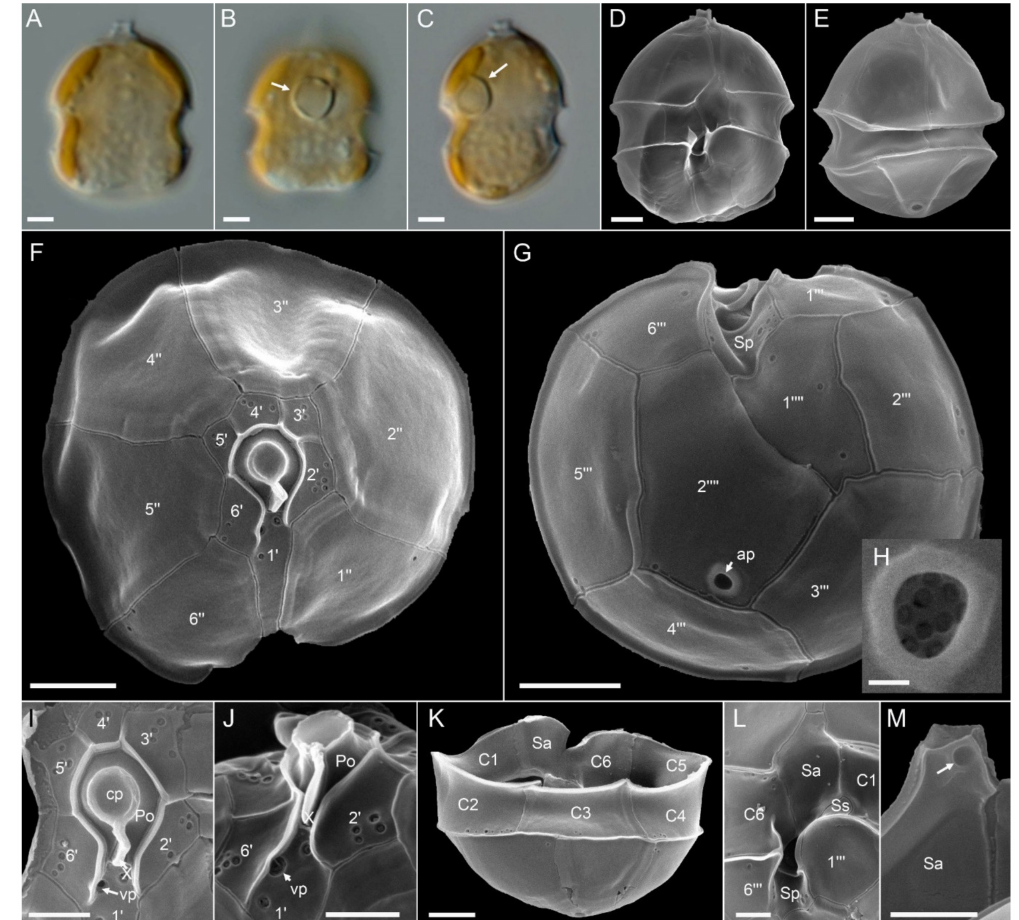
Figure 8. Amphidoma languida strains. ( A – C ) LM images of living cells to indicate general size and shape. Note the distinct pyrenoid in the episome (arrows in B , C ). ( D – M ) SEM images of different thecae. ( D ) Ventral view. ( E ) Dorsal view. ( F ) Apical view of epithecal plates. ( G ) Antapical view of hypothecal plates. Note the antapical pore (ap). ( H ) Enlarged view of the antapical pore. ( I ) Detailed view of the apical pore complex (APC). ( J ) APC in ventral view, note the position of the ventral pore (vp). ( K ) Hypotheca in dorsal view. ( L ) Detailed view of sulcal plates. ( M ) Detailed view of the anterior sulcal plate. Note the anterior round ventral depression (arrow). Plate labels according to the Kofoidian system. ap = antapical pore; cp = cover plate; Po = pore plate; vp = ventral pore; X = X-plate or canal plate. Abbreviation of sulcal plates: Sa = anterior sulcal plate; Sd = right sulcal plate; Sm = median sulcal plate; Sp = posterior sulcal plate; Ss = left sulcal plate. Scale bars = 2 µ m ( A – G , K ) or 1 µ m ( I , J , L , M ) or 0.2 µ m ( H